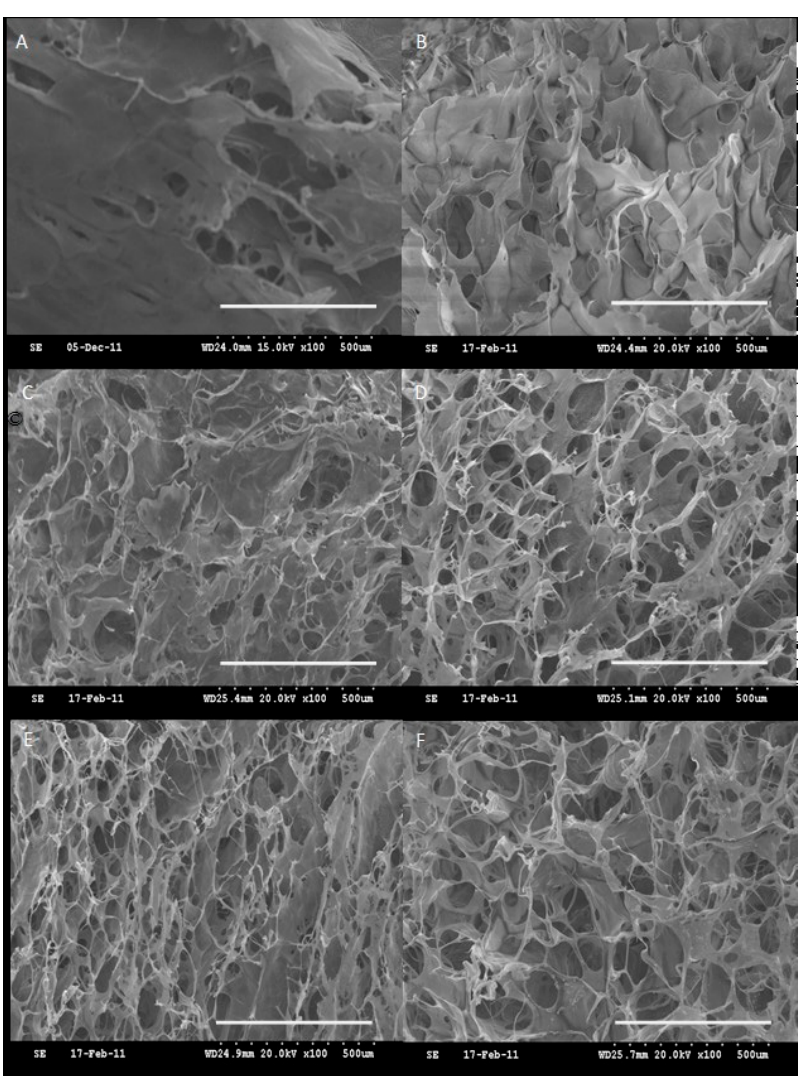
Figure 2. SEM morphology (scale bar = 500 µm) of ( A ) lyophilized collagen and oxi-HA/collagen hydrogel (CH) at different concentrations ( w / w ) after brief fixation and serial dehydration; with the connective pores clearly shown in ( B ) CH-10%; ( C ) CH-20%; ( D ) CH-30%; ( E ) CH-35% and ( F ) CH-40%.